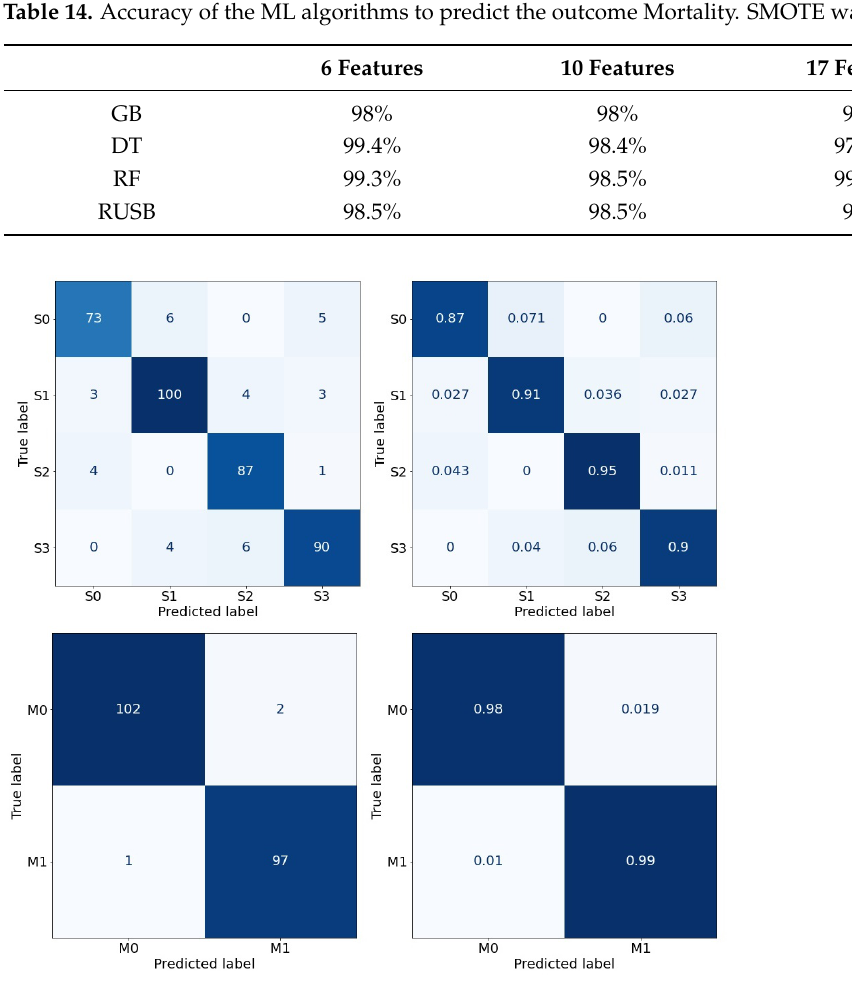
Figure 5. SMOTE—Random Forest classifier, Severity ( top )—Accuracy: 90.7%. RUS Boosting classifier, Mortality ( bottom )—Accuracy: